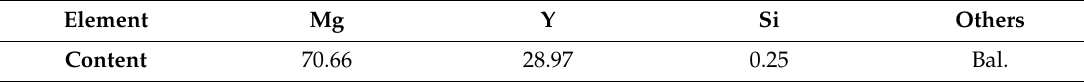
Table 2. The composition of Mg-30%Y alloy (wt %).